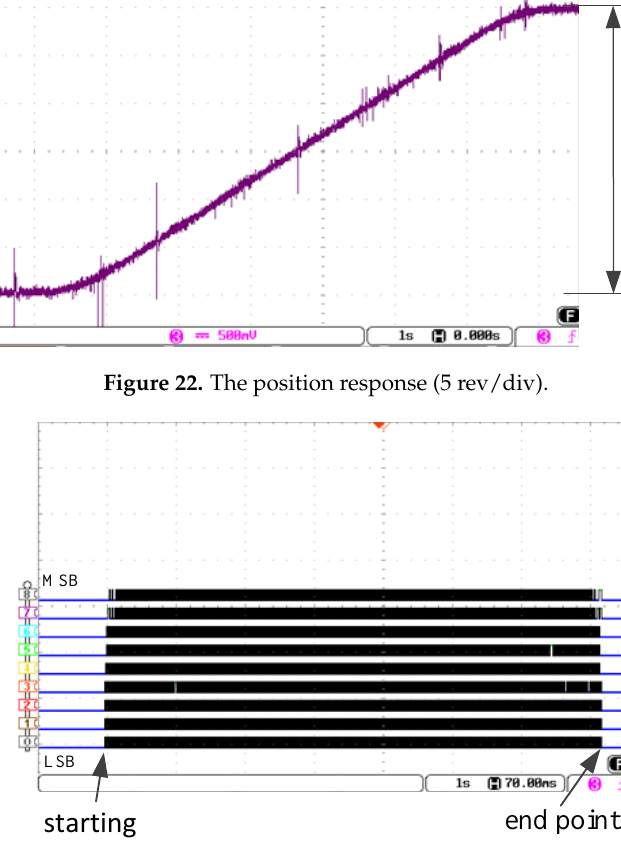
Figure 23. The logical analyzer output for position response.